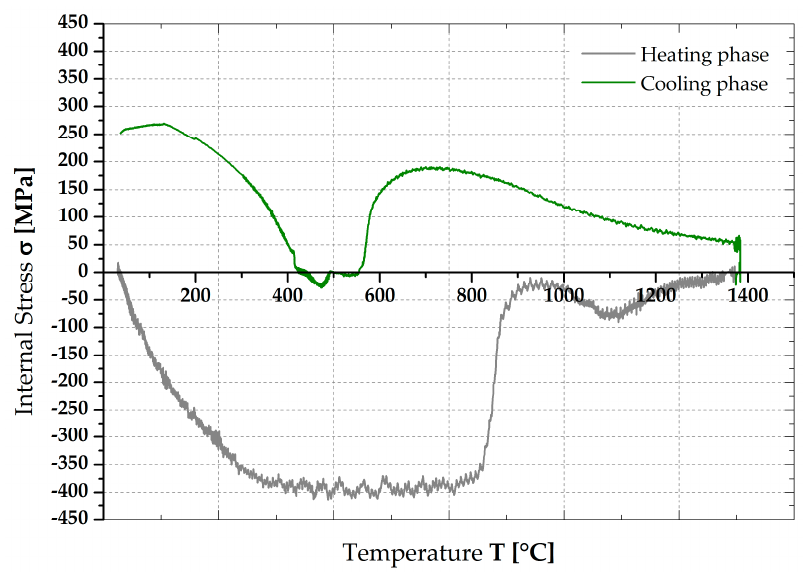
Figure 11. Graph of the dependence of the stresses in the sample on the temperature when applying a temperature cycle with zero dilatation, with a recording frequency of 500 Hz.